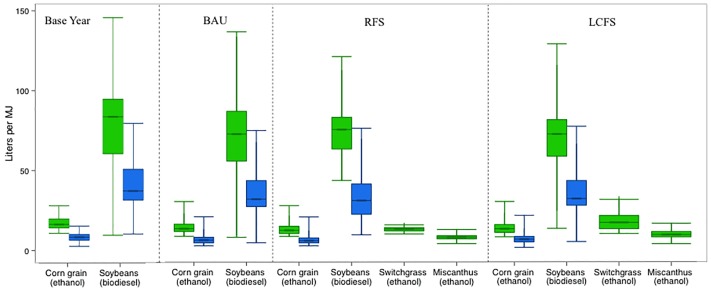
Green (soil water and rainfall) and blue (irrigation) water footprint of feedstock cultivation in the base year, no-policy counterfactual (BAU), Mandate, and CFS scenarios.Box plots show the area-weighted 5th, 25th, mean, 75th and 95th percentiles.